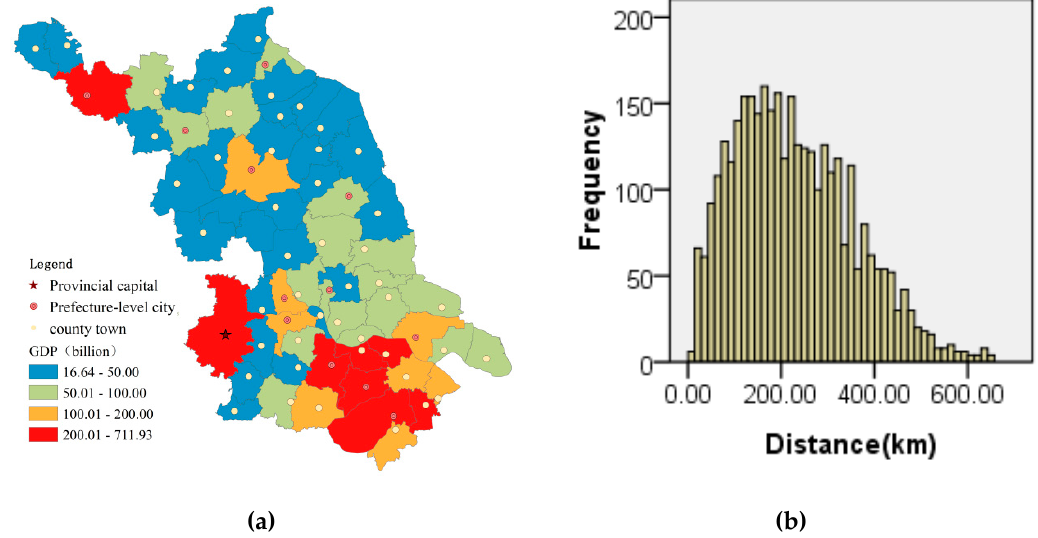
Figure 6. Distribution of variables. ( a ) Spatial distribution of GDP; ( b ) histogram of the distance.